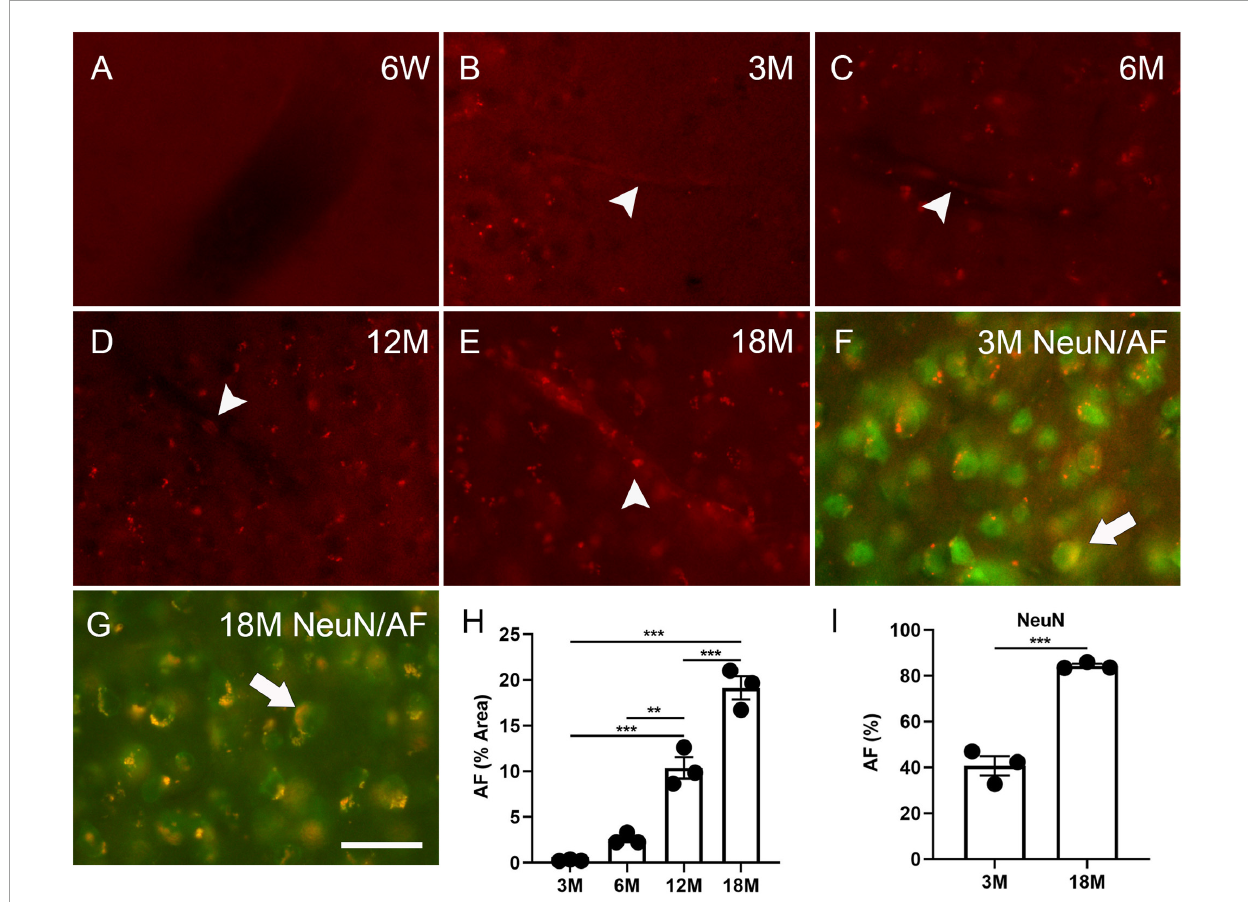
FIGURE1 Autofluorescence (AF) in the cortex of mouse brains at specific ages. The representative images of AF at 6 weeks (6W, A ), 3 months (3M, B ), 6 months (6M, C ), 12 months (12M, D ), 18 months of age (18M, E ). Blood vessel-like AF was found at 3 months of age and older (arrowheads, B–E ). The representative images of AF (red) co-localized with NeuN (green) at 3 months and 18 months of age (arrows, F,G ). Area percentage of AF at different ages and in neurons at three and 18 months of age (H,I) . The scale bar represents 20 µ m. The data are represented as mean ± SE. Significance analysis with one-way analyses of variance (ANOVA) followed by Tukey’s multiple comparisons test or t -test. ** p < 0.01, *** p < 0.001.